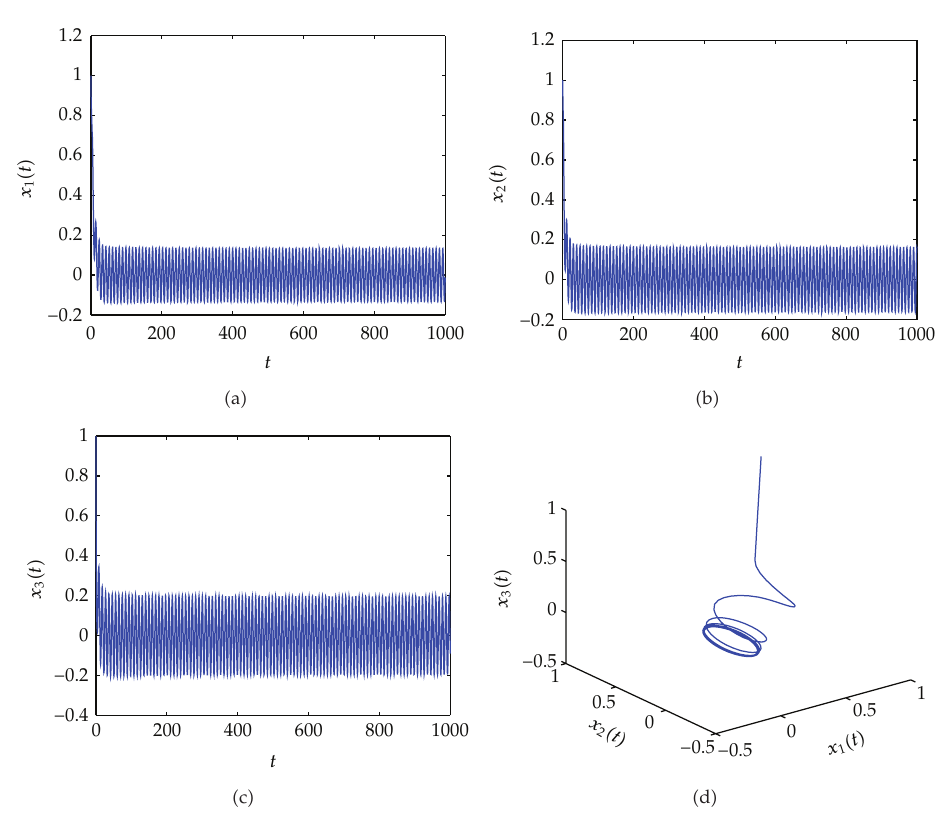
Figure 3: When τ (cid:7) 1.9 > τ 0 (cid:7) 1.8434, a periodic orbit bifurcates from the zero equilibrium. Here, initial value is (cid:5) 1, 1, 1 (cid:6)